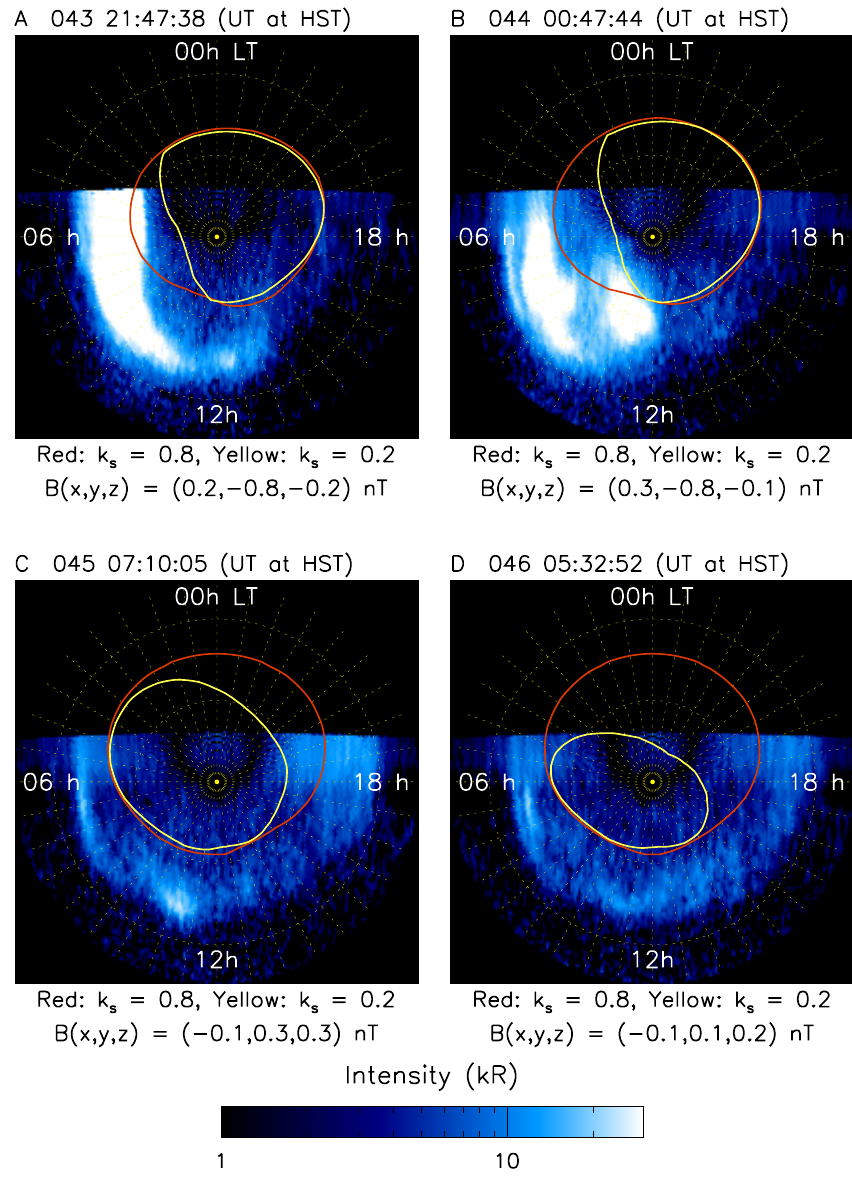
Fig. 5. Plots showing HST UV images of Saturn’s southern auroras, projected onto a spheroidal surface 1100km above the 1bar level, with noon at the bottom and dawn to the left. Image identifiers are given at the top of each panel together with the start time of the ∼ 20min combined exposure time as given in Table 1. The superposed solid lines show the calculated open field regions for k s =0.8 (red) and k s =0.2 (yellow), using the corresponding averaged IMF vector determined from Cassini data, as indicated at the bottom of each